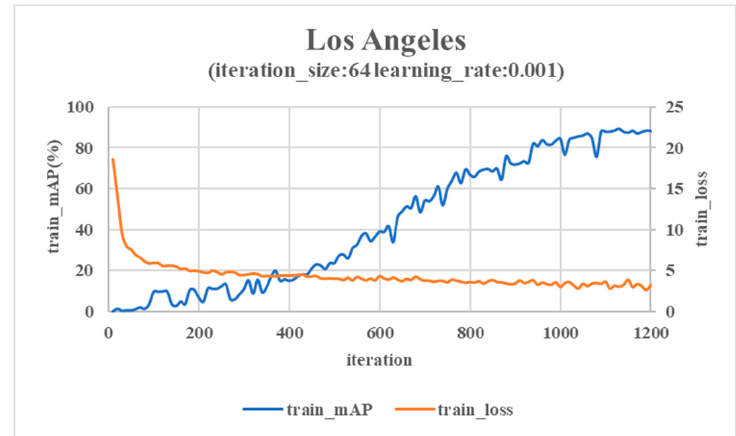
Figure 13. mAP and loss variation of the Los Angeles training data set when the size of each training set is 64.